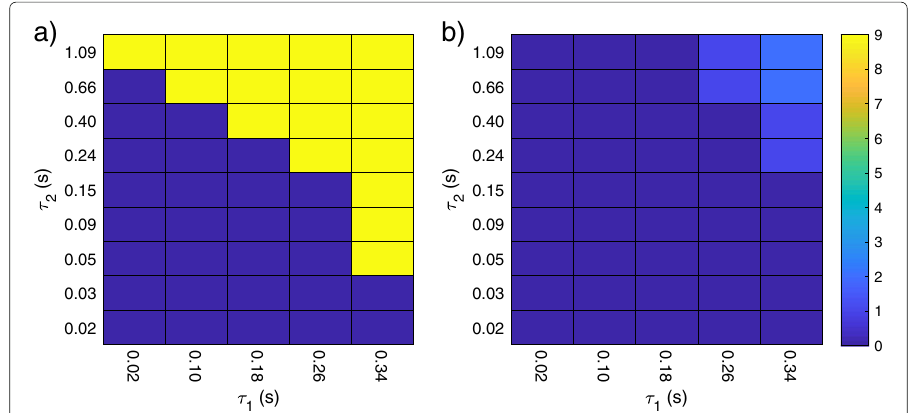
Fig. 6 Sample Instability Frontiers in Fault-Time Parameter Space. Sample results of simulations over a region of fault-time parameter space. Each box represents a simulation with fault times (τ 1 , τ 2 ) , with its color denoting the number of generator buses which exhibited unstable dynamics. A set of simulations like this was carried out for each line in the network. Examples are presented for a ) a fault location likely to induce CSI, and b ) a fault location unlikely to induce CSI. Note: the color scale is produced by ennumerating unstable generator buses (just those marked by squares in Fig. 1) so a count of 9 corresponds to the whole